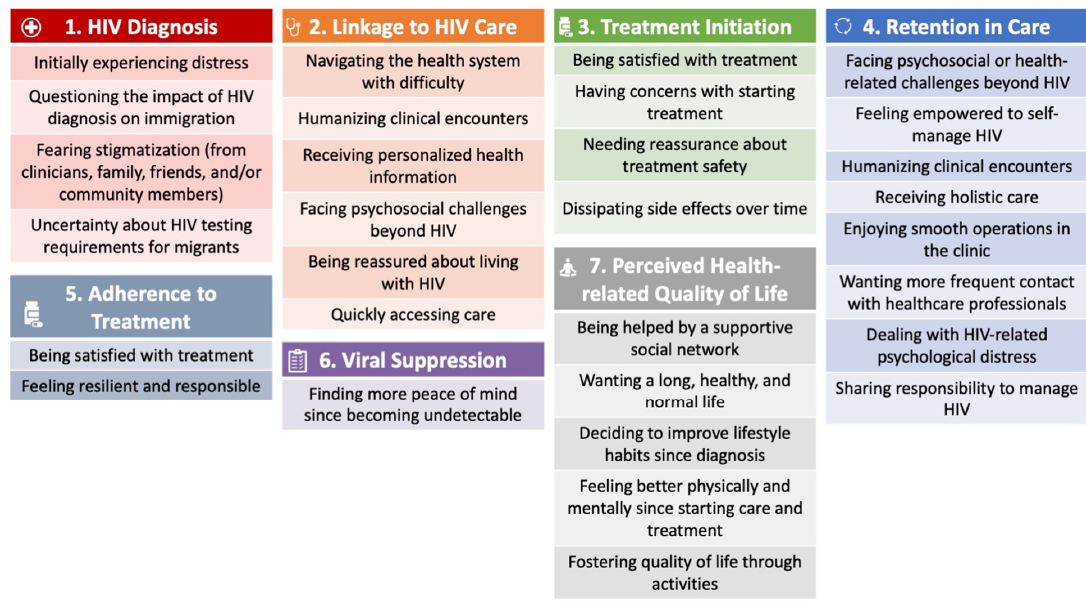
Figure 1. Main categories of MLWH experiences by step of the HIV care cascade. Table 2. Data framework matrix for MLWH experiences.